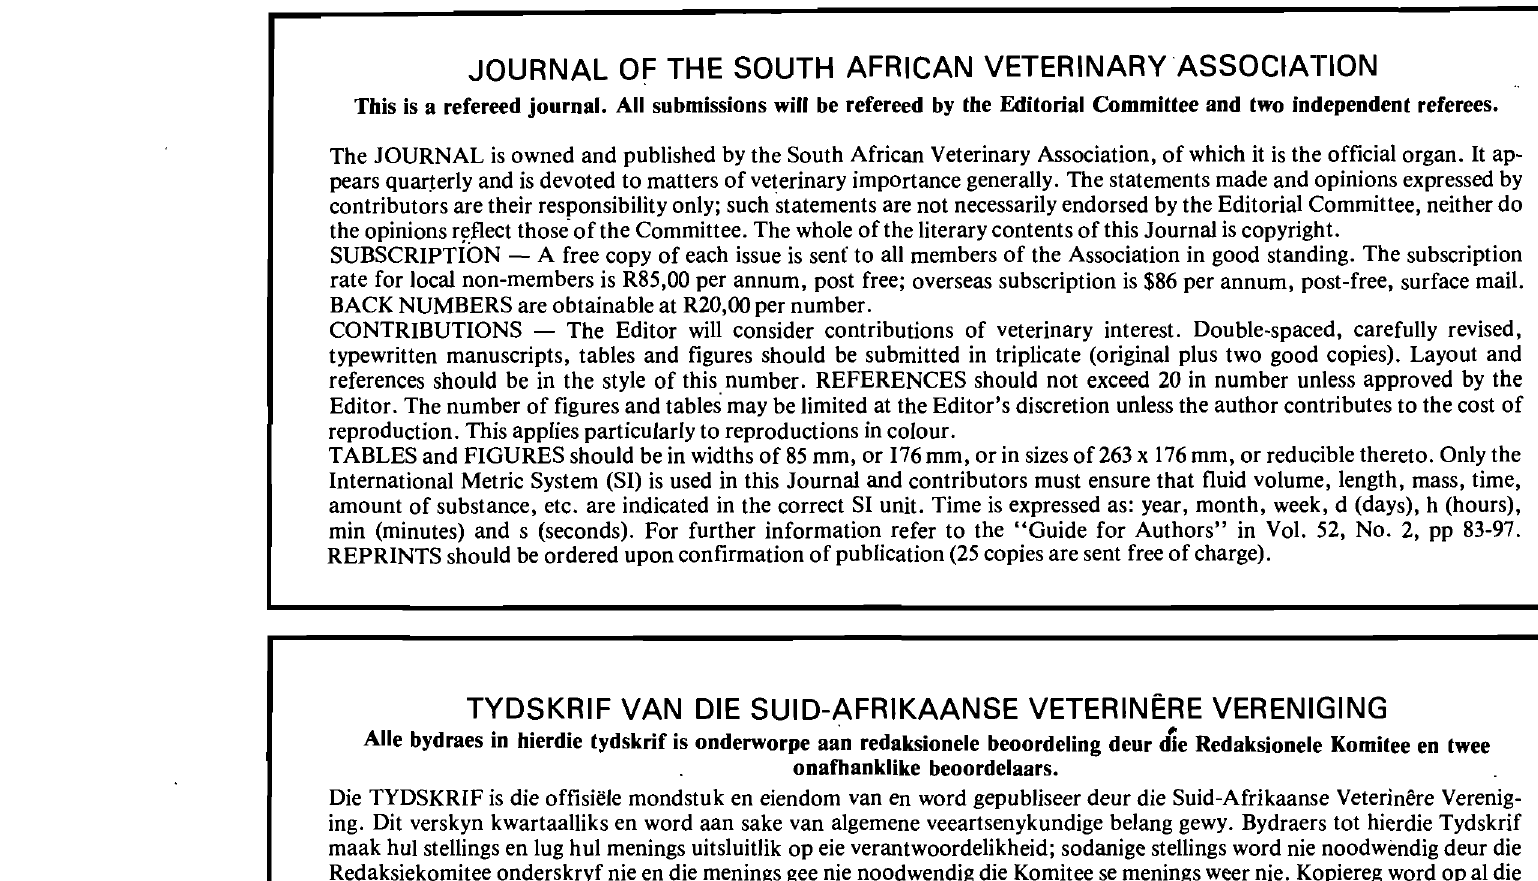
TYDSKRIF VAN DIE SUID-AFRIKAANSE VETERINERE VERENIGING Aile bydraes in hierdie tydskrif is onderworpe a~n redaksionele beoordeling deur die Redaksionele Komitee en twee onafhanklike